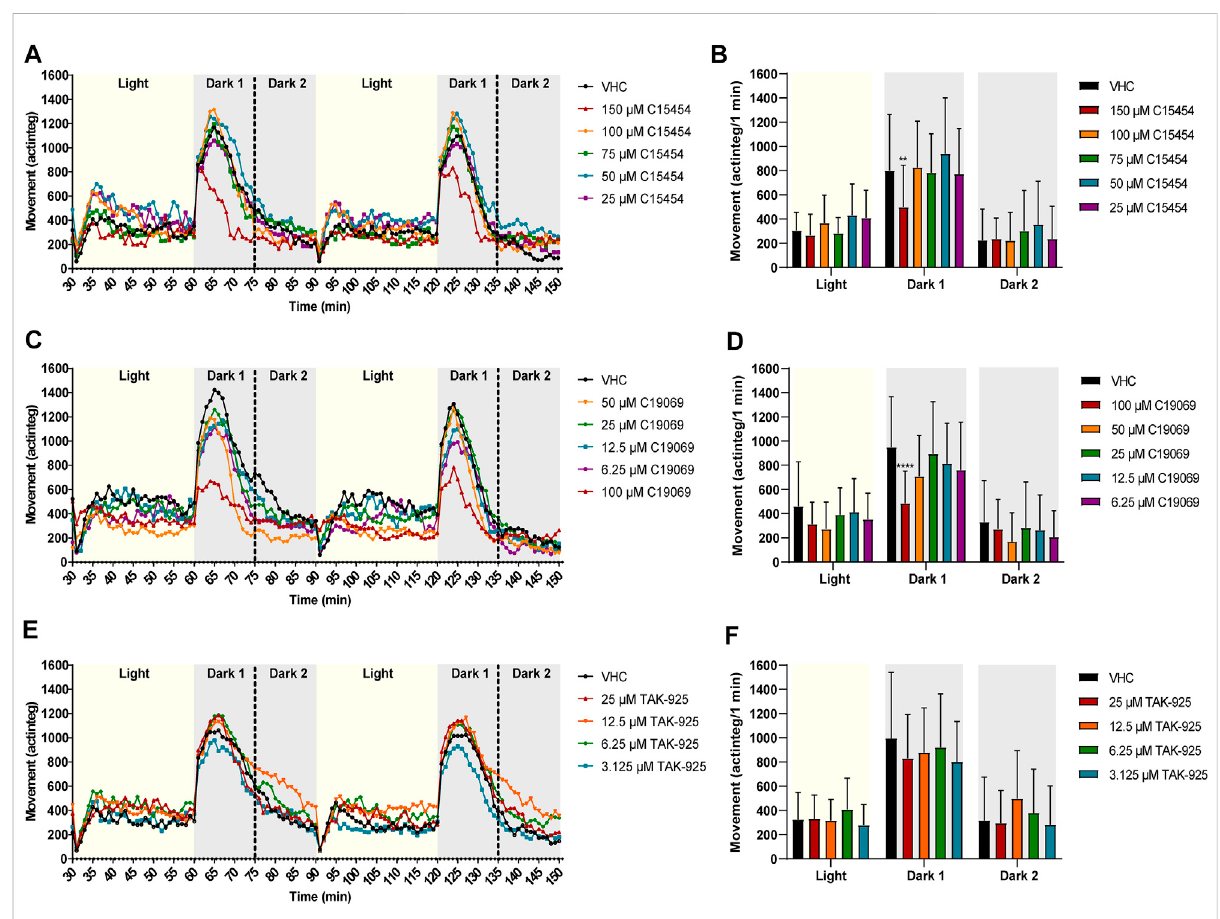
FIGURE 7 Behavioral analysis of 6-dpf zebra fi sh larvae treated with orexin 2 receptor agonists in the dark-light assay. Locomotor pro fi les of animals are expressed as mean actinteg units per 1 min treated with C15454 (A) , C19069 (C) and TAK-925 (E) are plotted as function of time. For the sake of clarity,standarddeviationsarenotshown.Differentphasesareshown,i.e.30minlightphase(Light),the fi rst15 minofthedarkphase(Dark1)andthe last15 minofthedarkphase(Dark2).Totallocomotoractivitywasaveraged(±SD)perrespectivelightordarkphase (B – F) .Foreachcompound, data were pooled from three or four independentexperiments with 9 – 20 replicate wells per test condition (n = 29 – 30, except for VHC (A,B) n = 50) and 6.25 — 12.5 µM C19069 ( n = 20)). Statistical analysis: two-way ANOVA with Dunnett ’ s multiple comparison test. Signi fi cance levels: ** p ≤ 0.01, **** p ≤